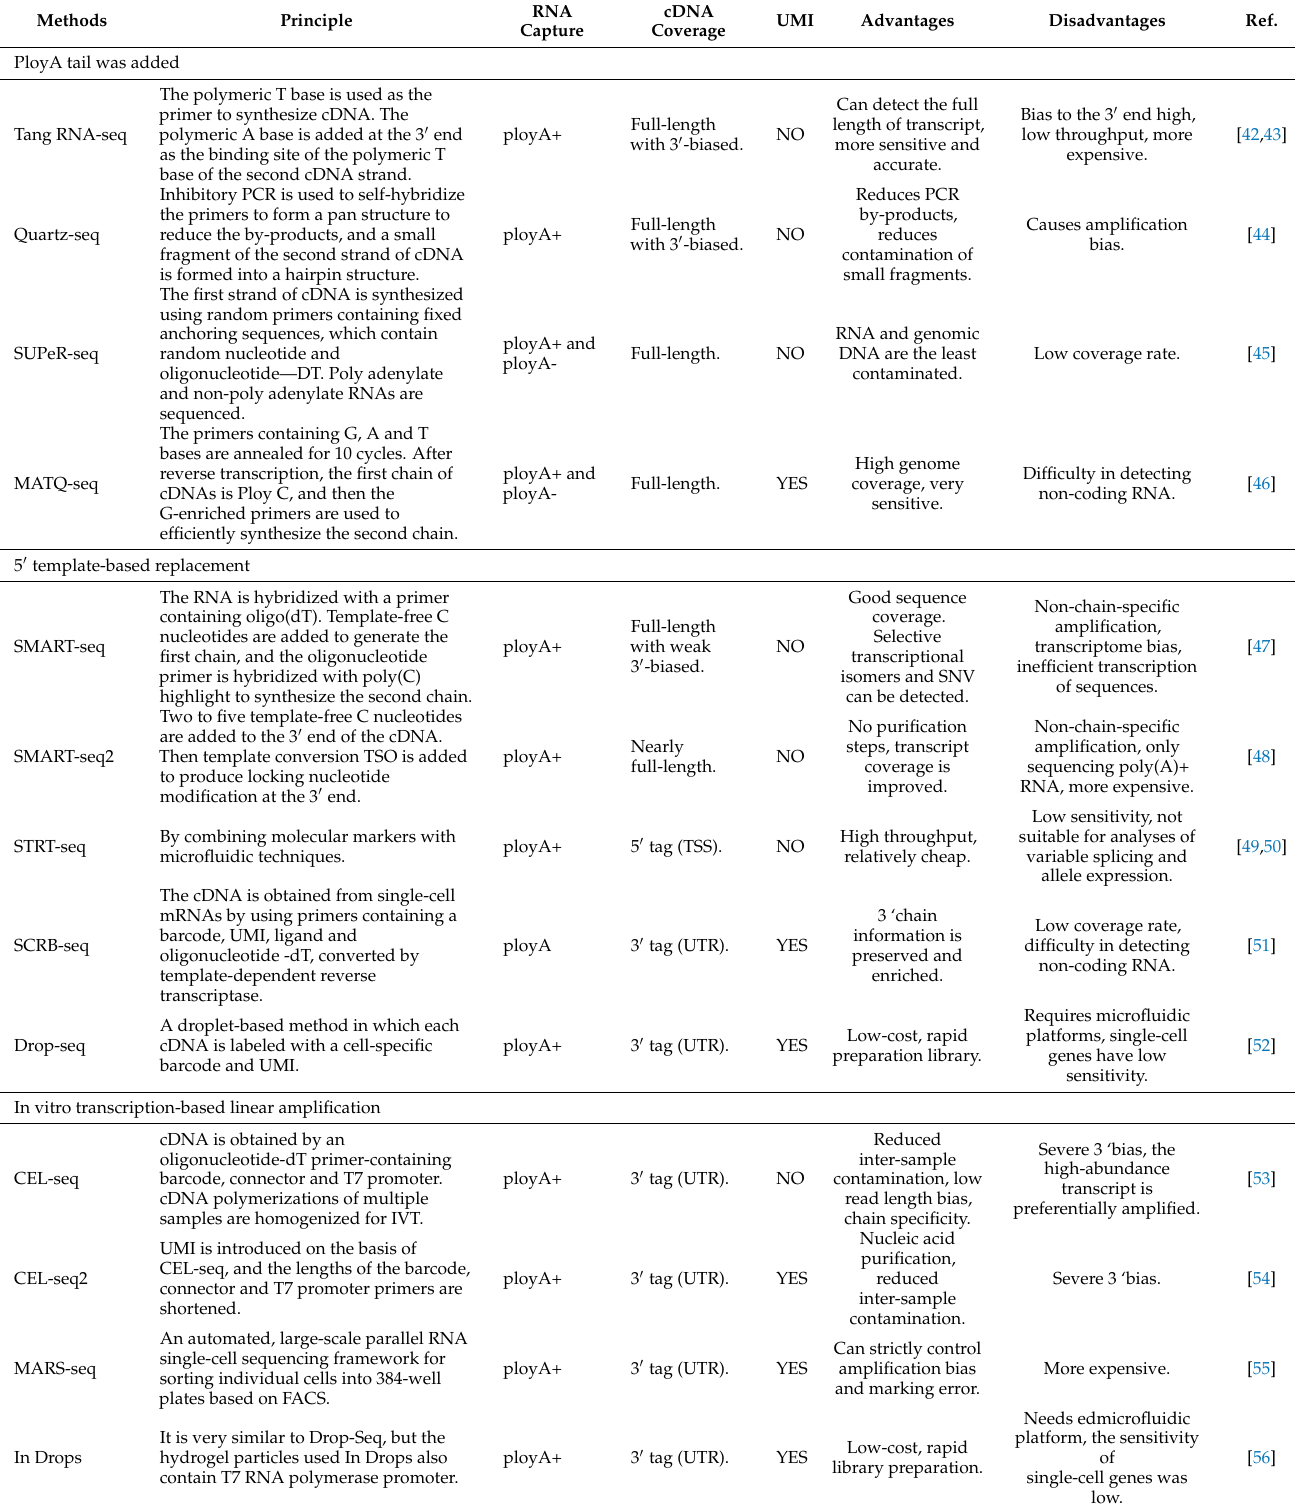
Table 4. Single-cell whole-transcriptome amplification